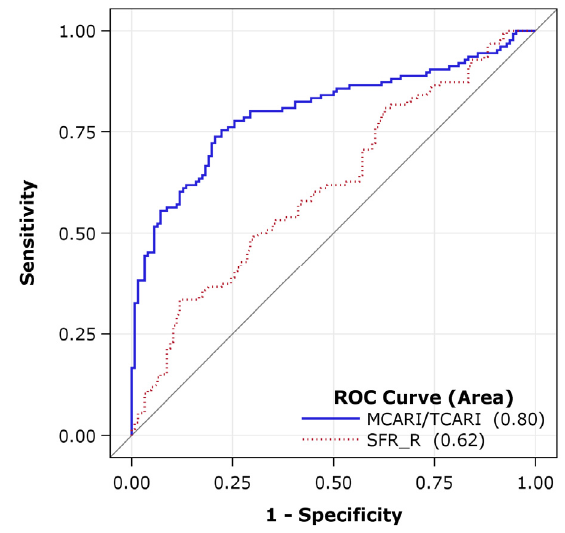
Figure 3. ROC plot shows the performances of MCARI/TCARI and SFR_R for the discriminating between the with- and without-fungicide treatments at the second sampling date (DAS 83). The area under ROC curves is 0.80 and 0.62 for MCARI/TCARI and SFR_R, respectively.